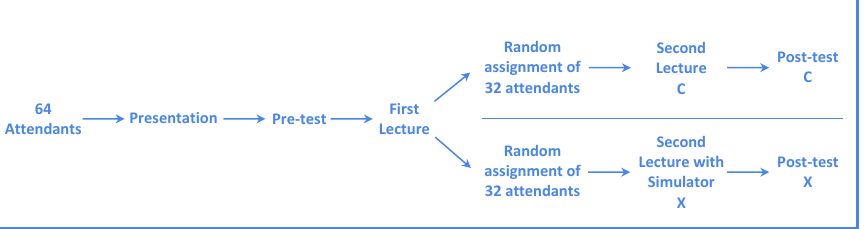
Figure 4. Study Design. Letter X refers to the experimental group, while C refers to the control